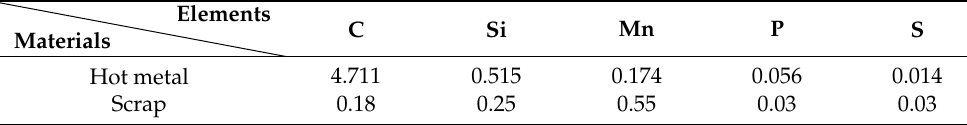
Table 1. Compositions of hot metal and scrap (wt%).